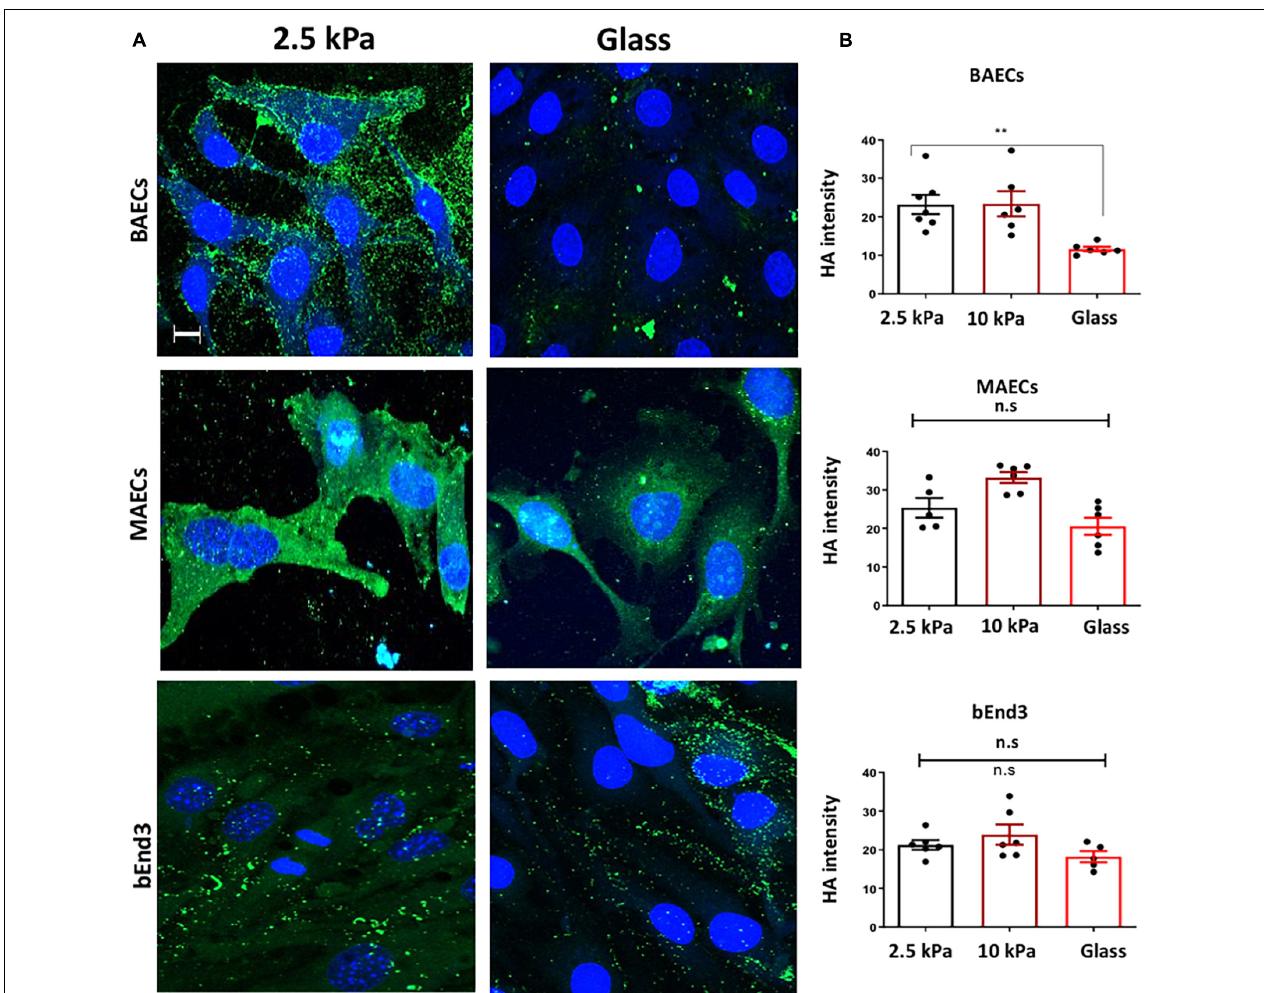
FIGURE 2 | Stiffness inhibits Hyaluronic Acid GAG expression on the surface of BAECs, but not MAECs and BEND3 cells. (A) BAECs, MAECs, and BEND3 were cultured onto polyacrylamide gels at stiffness of 2.5 kPa (soft gel), 10 kPa (stiff gel) or on glass until confluent. Hyaluronic Acid (HA) (green) expression was assessed by immunostaining. Cell nuclei were identified using DAPI 4 (cid:48) ,6-diamidino-2-phenylindole (DAPI) (blue). Scale bar = 10 µ m. (B) Hyaluronic Acid expression was quantified as fluorescent intensity. Mean values ± SEM are shown. N = 6. * P < 0.05 and ** P < 0.01 using a One-way ANOVA test. N.S indicates no statistically significant difference was